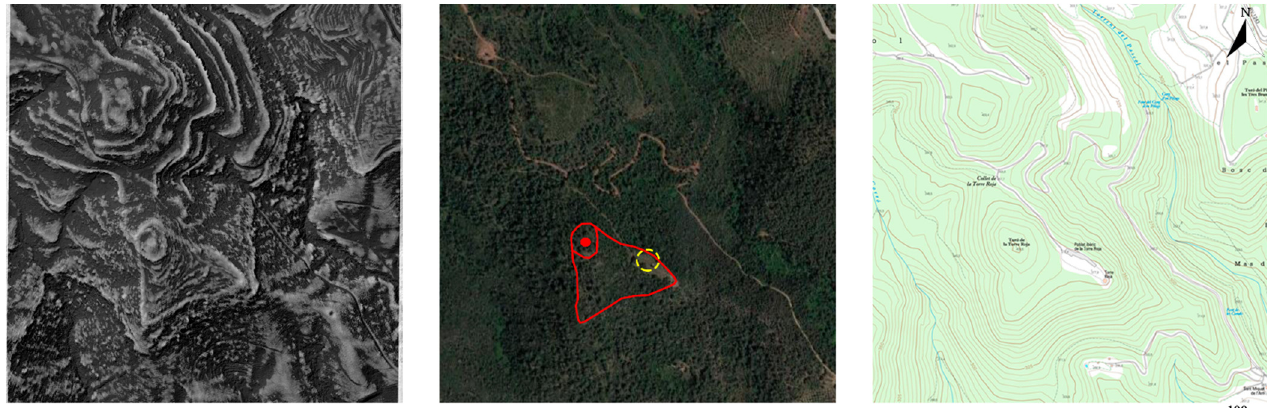
Figure 9. MSRM ( left ), satellite view ( centre ) and topographic map ( right , forest in green) of the Torre Roja site. In the satellite image the walls (red) and the known location of the settlement (yellow) are indicated.